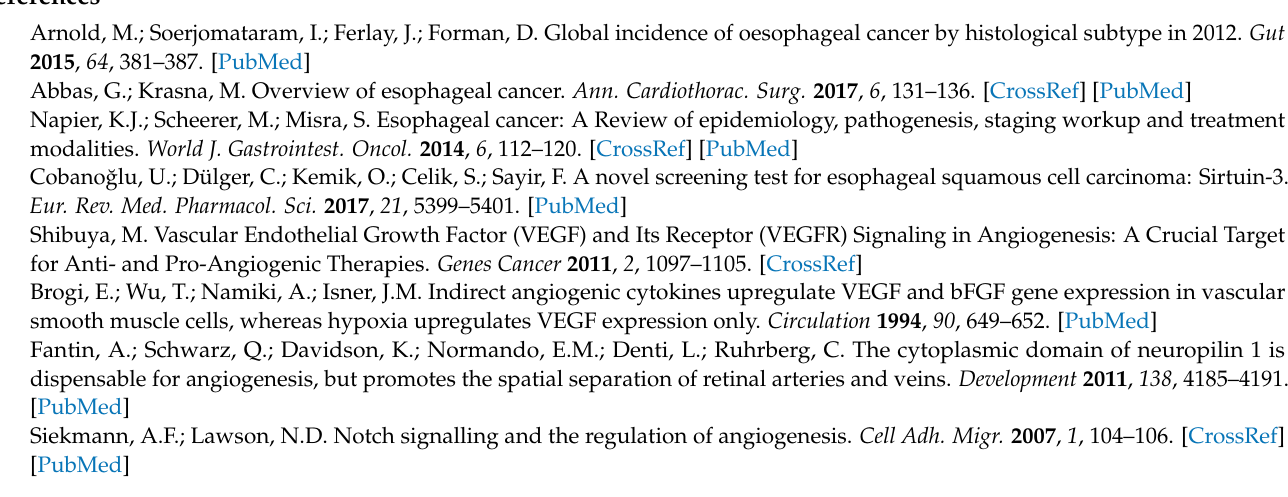
Figure S2. A stratified K-M survival analysis across different clinical features in GSE53622. Univariate (A) and multivariate (B) Cox regression analyses of the association between clinicopathological factors and overall survival (OS) of patients. (C) KM survival curves (high-risk vs. low-risk patients) for overall survival in multiple subgroups. Figure S3. Construction of a nomogram for survival prediction in GSE53622. (A) Nomogram model consisting of stage and risk score factors for 1-, 2-, 3-, and 4-year OS prediction. (B) Calibration curves showing the nomogram-predicted survival probabilities corresponded closely to the actual observed proportions in 1-year prediction. Table S1. Primer sequences for Real Time quantitative PCR. Table S2. The results of KEGG pathway and GO function analyses on